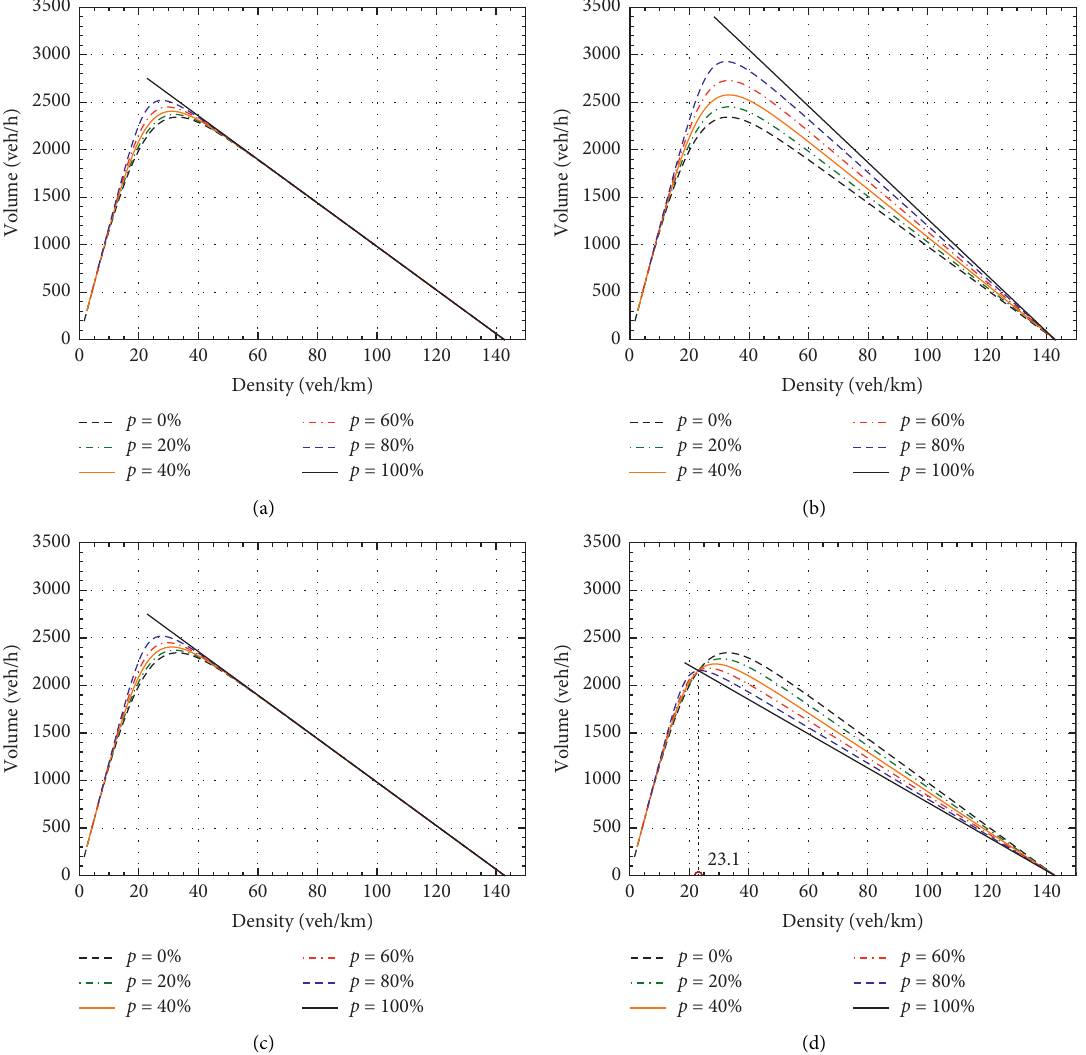
Figure 8: The fundamental diagram of mixed traffic with different desired time gap policies. (a) CTG policy with t with t max h